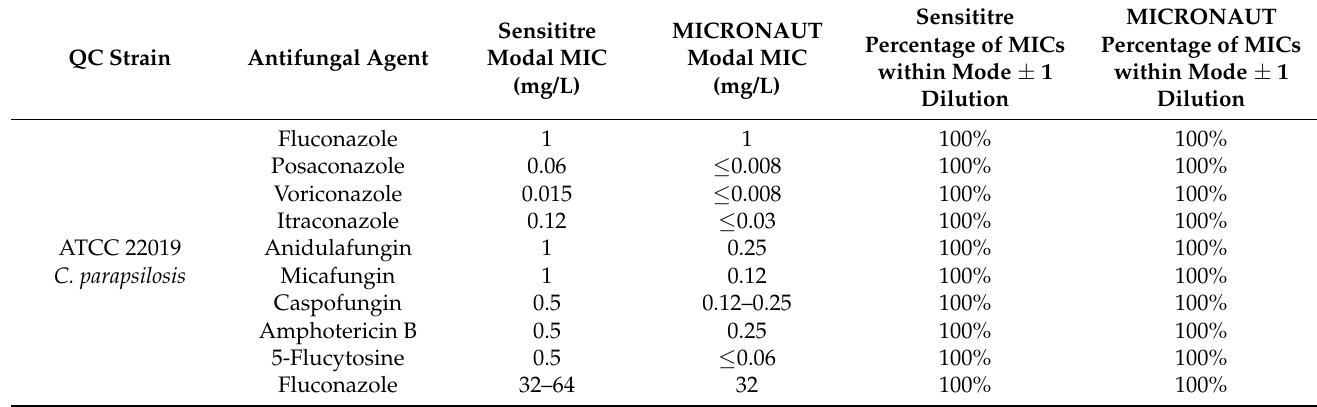
Table 2. The intralaboratory reproducibility for SY and